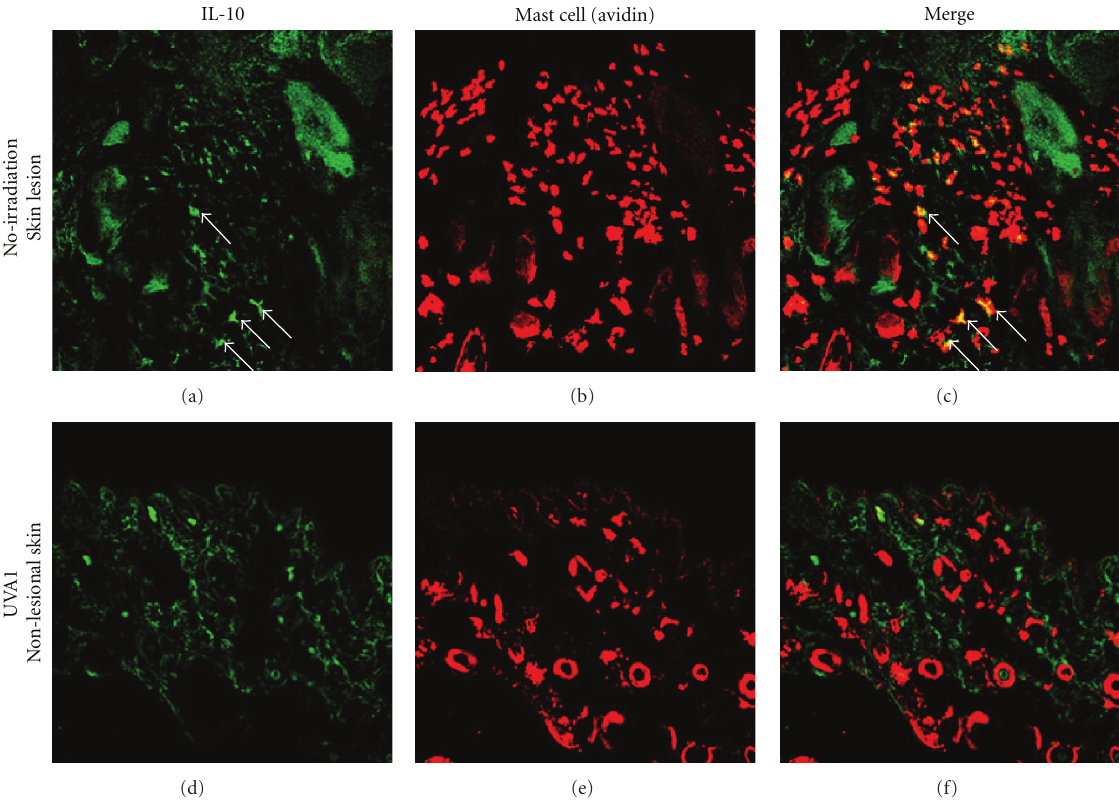
Figure 5: Analysis of the production of IL-10 by mast cells in MRL/lpr mice. (a), (b), (c): spontaneous LE-like skin lesion of nonirradiated mice. (d), (e), (f): nonlesional skin of UVA1-irradiated (10J/cm 2 ) mice. Mast cells are labeled with avidin-Texas Red in red, while IL-10 is immunostained with anti-IL10 mAb and Alexa Fluor 488-conjugated secondary Ab in green. In the LE-like skin lesions, some double immunopositive IL-10-producing mast cells were seen (yellow in (c), indicated by arrows). In contrast, in the nonlesional skin of UVA1- irradiated (10J/cm 2 ) mice, such cells were not detected (f). (a), (d): immunostain for IL-10, (b), (e): immunostain for mast cells, (c), (f): merged images, original magnification, ×